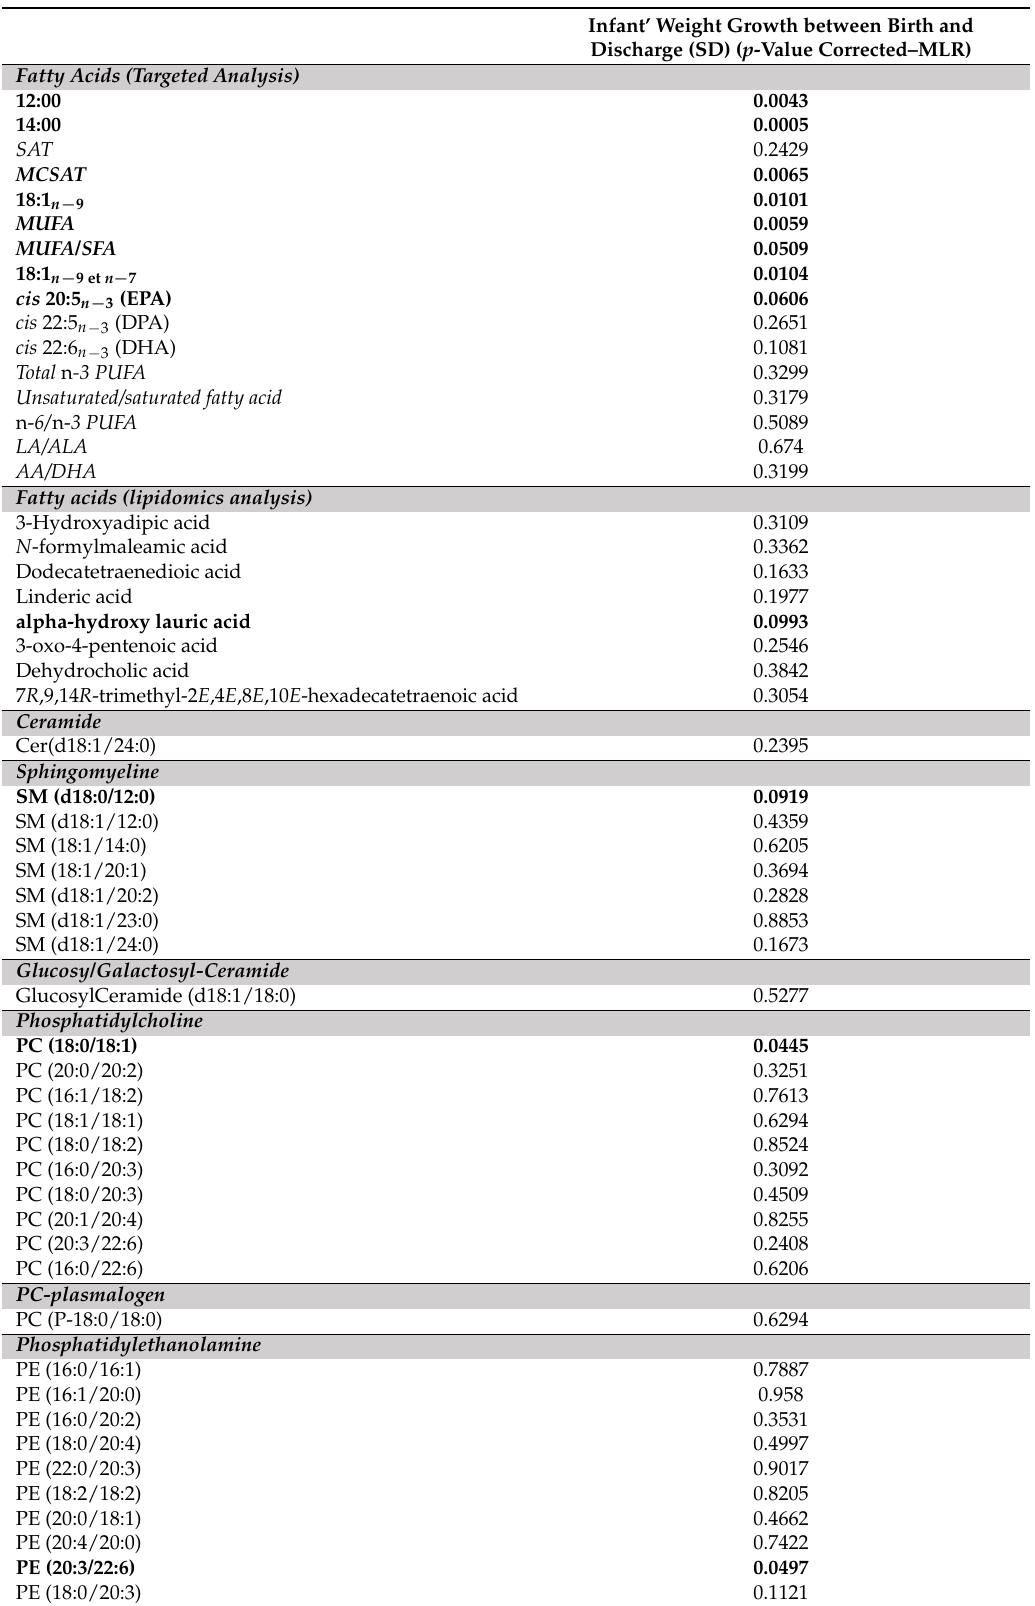
Table 4. Predictive ability of tentative lipid and fatty acid biomarkers on infant’ growth (defined based on the difference between discharge and birth weight Z -score). Infant’ Weight Growth between Birth and Discharge (SD) ( p -Value